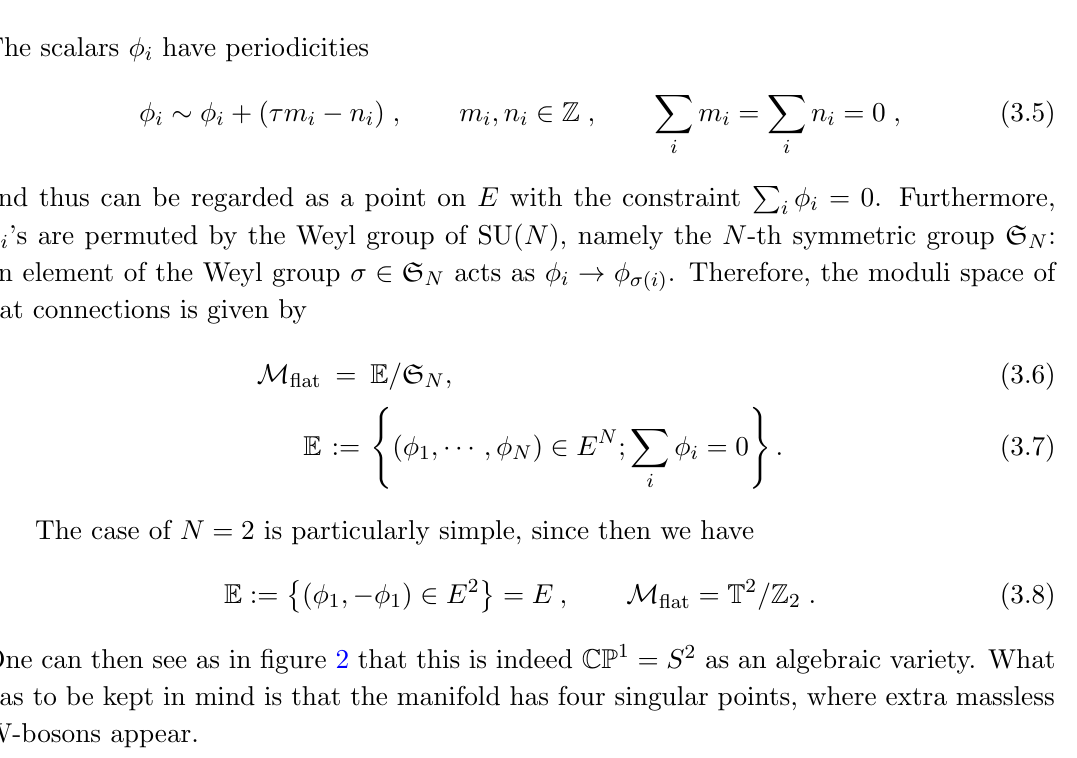
Figure 2 . For the case N = 2, the moduli space of (cid:13)at connections M (cid:13)at on E = T 2 is T 2 = Z 2 , which as in this (cid:12)gure can be identi(cid:12)ed with CP 1 . The four (cid:12)xed points of T 4 = Z 2 are mapped into the four singular points on CP 1 , represented by black